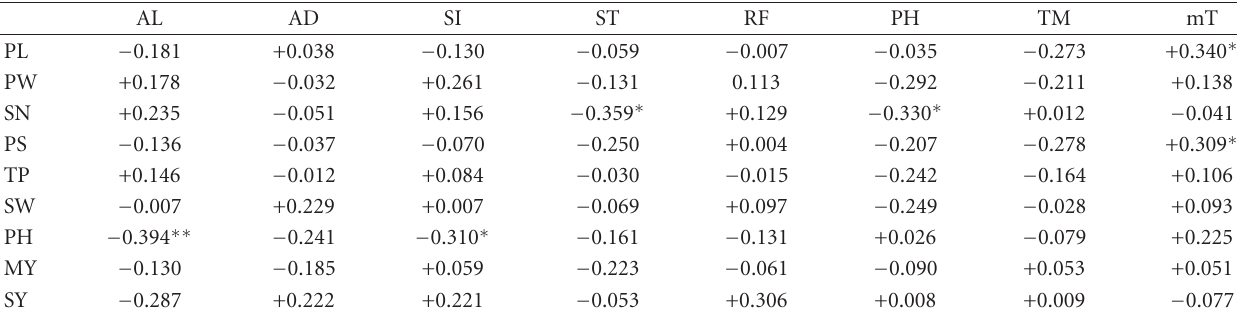
Table 4: Correlations between agronomic characters and pedoclimatic factors of tall fescue.